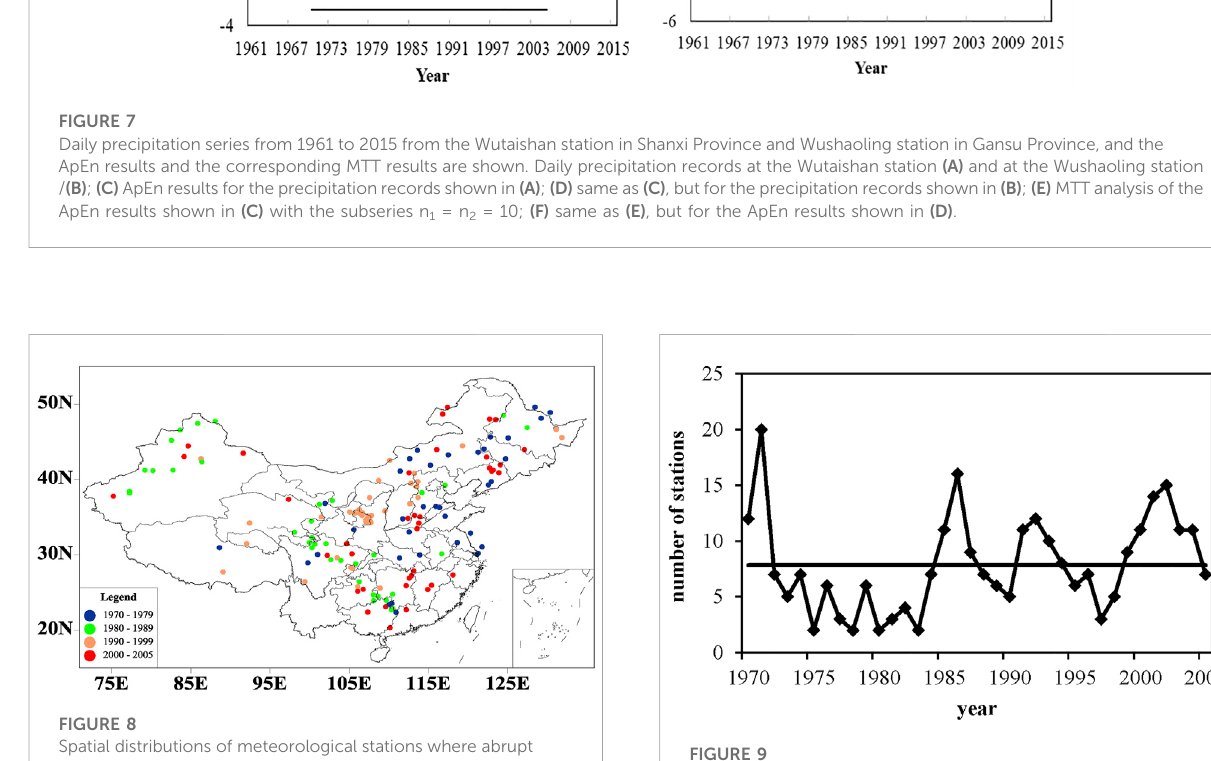
FIGURE 9 Time variations of the number of stations where the ApEn values have an abrupt